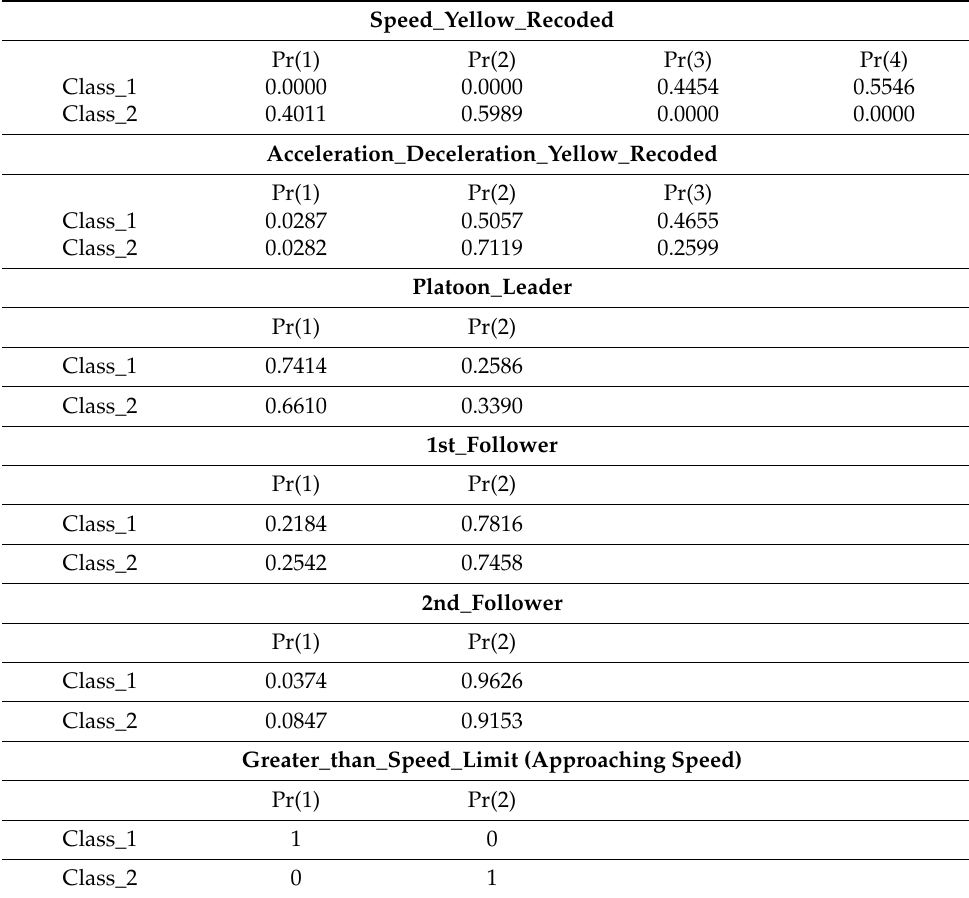
Table 6. Conditional item response (column) probabilities by outcome variable for each class